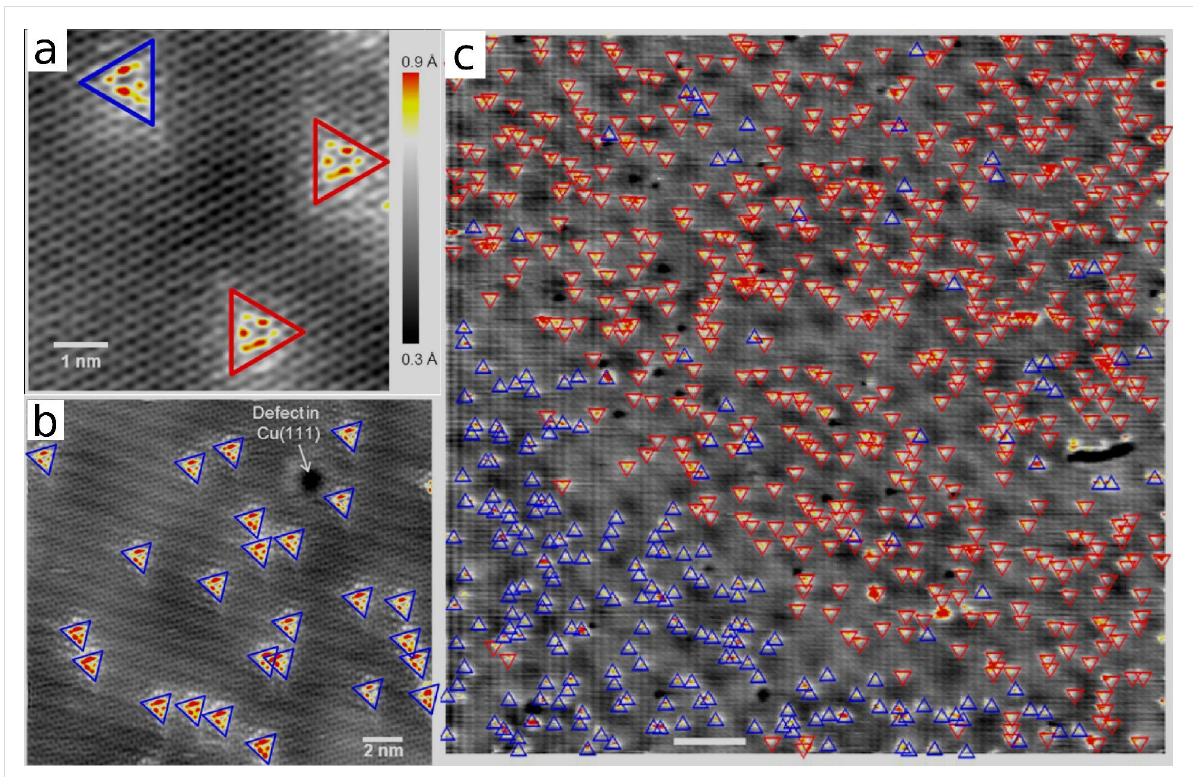
Figure 2: STM images of nitrogen doped graphene on (a) 7 nm 2 , (b) 20 nm 2 and (c) 100 nm 2 scales, adapted with permission from Zabet-Khosousi et al. [41]. Copyright 2014 American Chemical Society. The dopants locations are identified by finding bright spots on the STM image, corresponding to slight perturbations in the positions of the neighbouring carbon atoms. The dopant sublattice can be found through the orientation of the bright triangle features, where opposite sublattices appear as mirror images of each other as demonstrated in (a). The red and blue triangles in each subfigure correspond to impurities on the different sublattices. Part (c) best demonstrates that although the distribution of dopants appears random, when their sublattice is identified we see two very large domains appear with opposite sublattice segregation. Shown at the bottom, off-center left of (c) is a white 10 nm